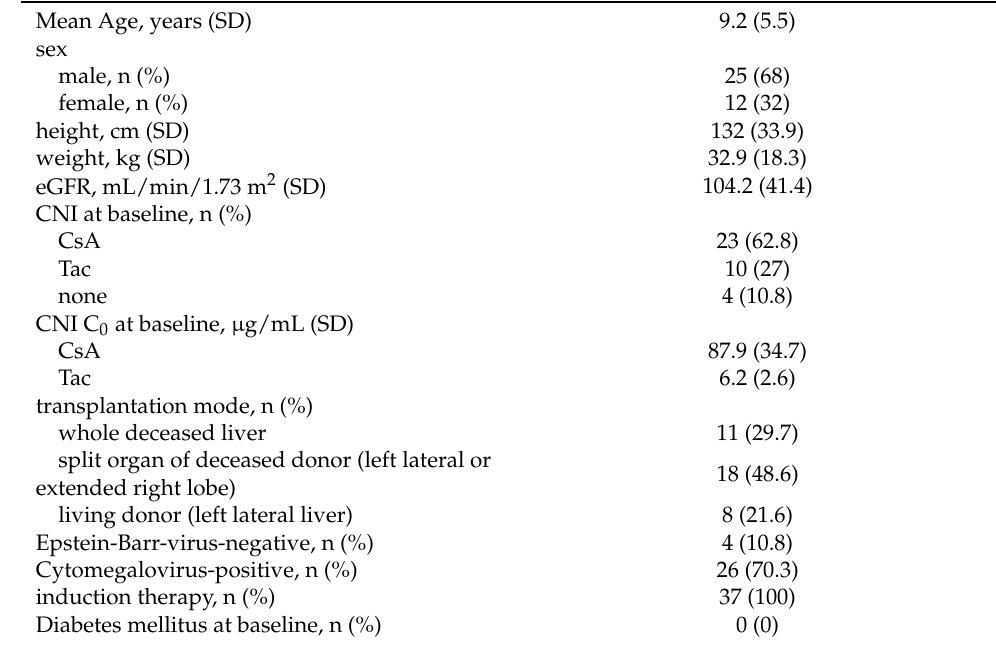
Table 2. Baseline